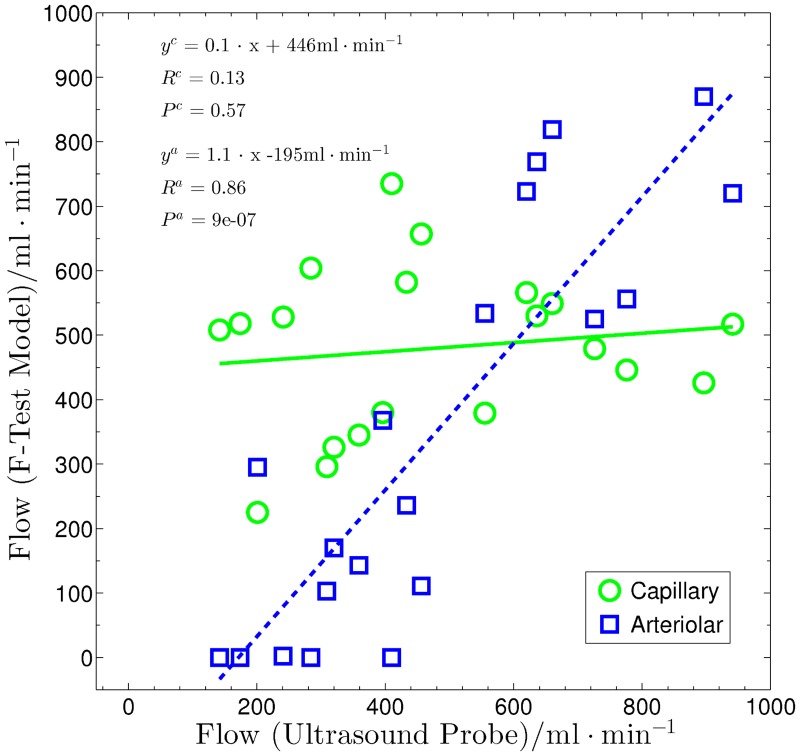
Regression of the corrected DCE-MRI model results.Regression of the corrected DCE-MRI model results with the Doppler flow values for the F-test selection method. The solid line represents the linear regression fit of the measured data with the capillary contribution of the model flow values (circles). The dashed line depicts the linear regression fit of the measured data with the arteriolar contribution of the model flow values (squares).